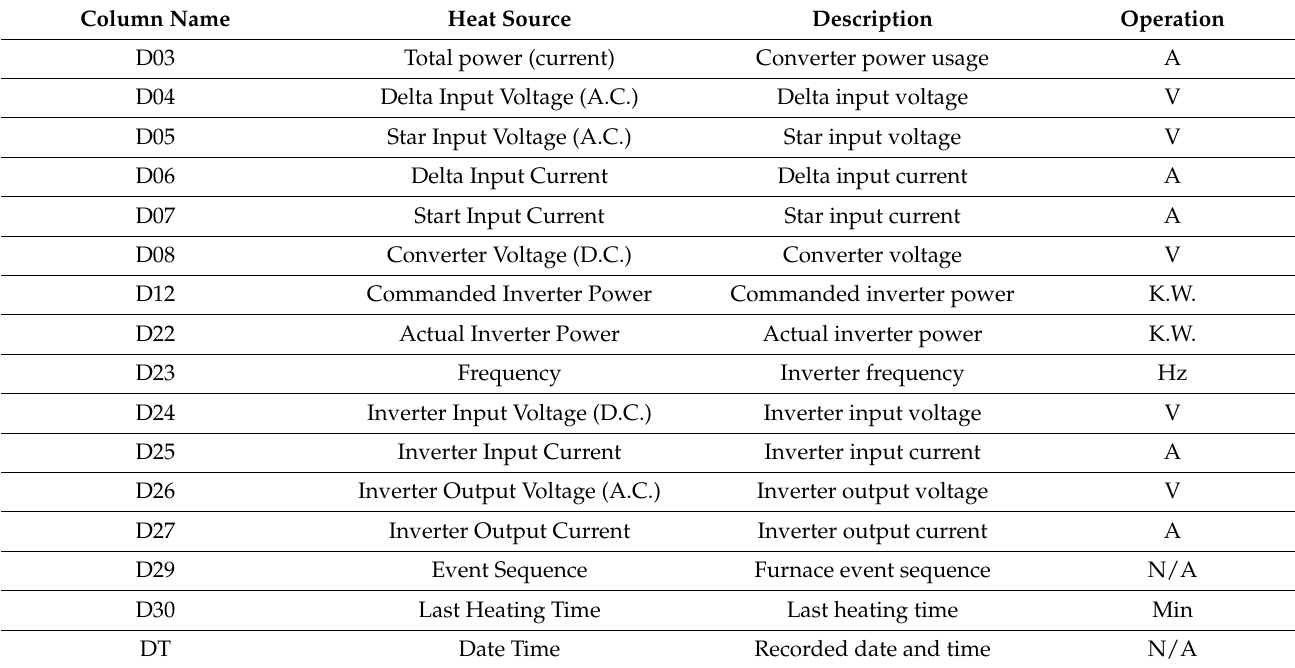
Table 3. Scheme of raw data.